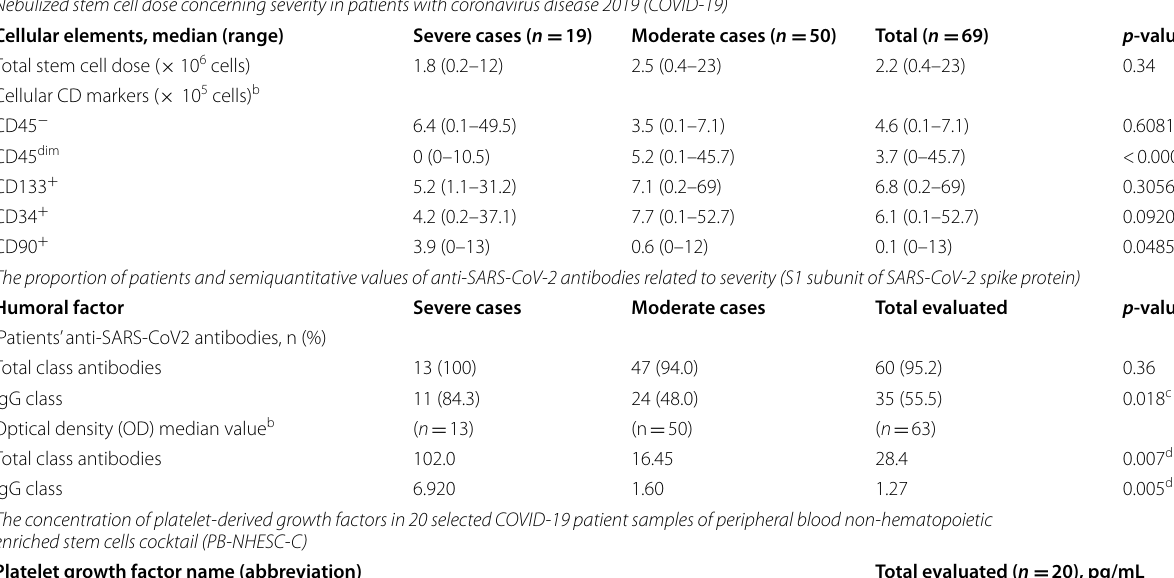
Table 2 Cellular and humoral components of the peripheral blood non‑hematopoietic enriched stem cell cocktail Nebulized stem cell dose concerning severity in patients with coronavirus disease 2019 (COVID-19)